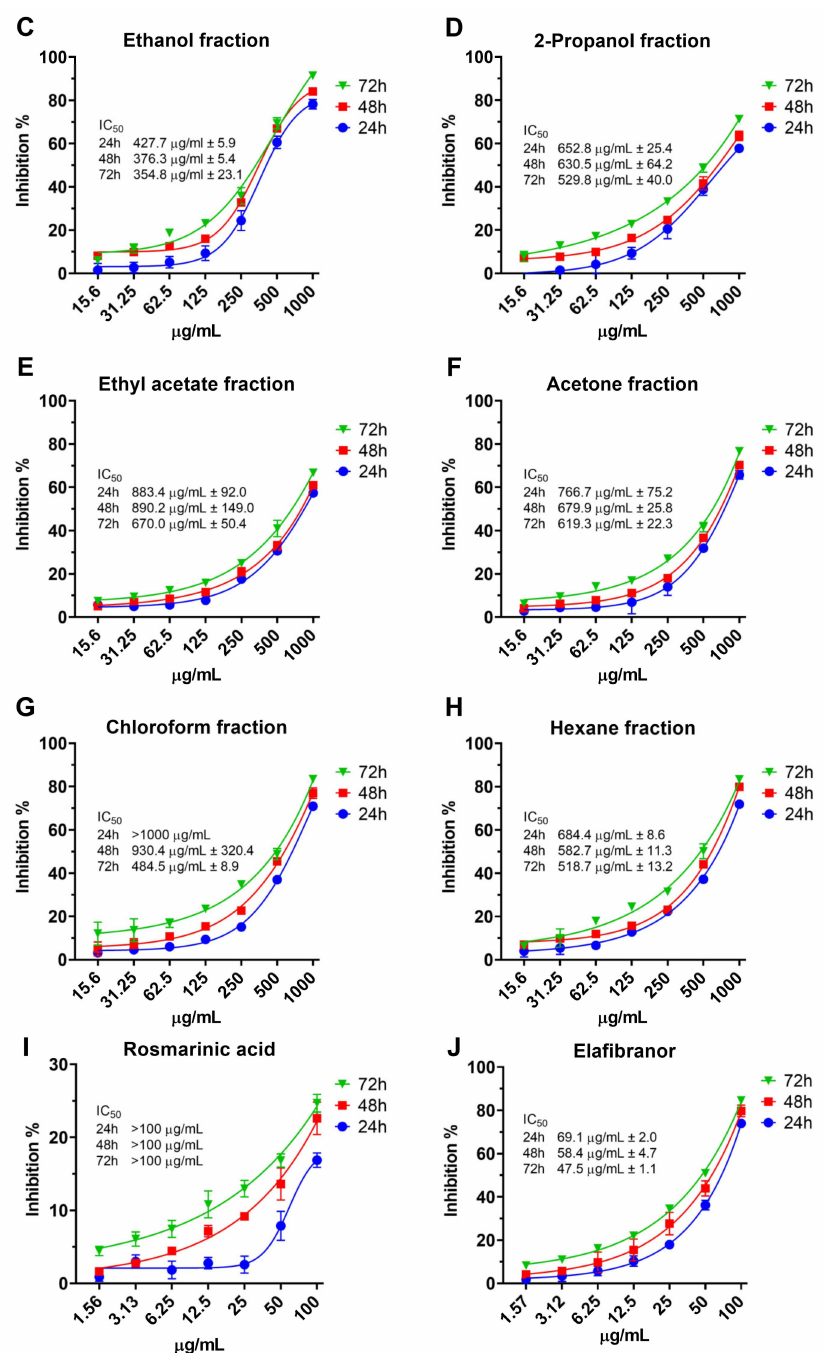
Figure 8. The cytotoxicity of O. aristatus fractions against HepG2 cells. Concentration scales were logarithmized to obtain relative response curves. Values were presented as mean ± SD, n =